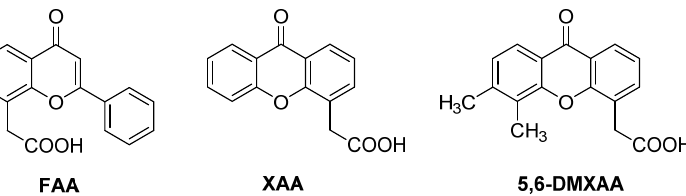
Figure 1. Structures of prototypes flavone-8-acetic acid (FAA), xanthone-4-acetic acid (XAA) and 5,6-dimethylxanthone-4-acetic acid (DMXAA).